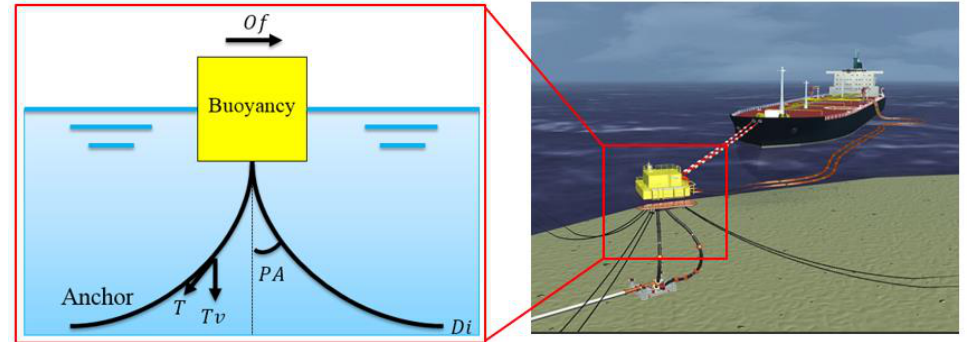
Figure 1. Schematic diagram of the catenary anchor leg mooring system.